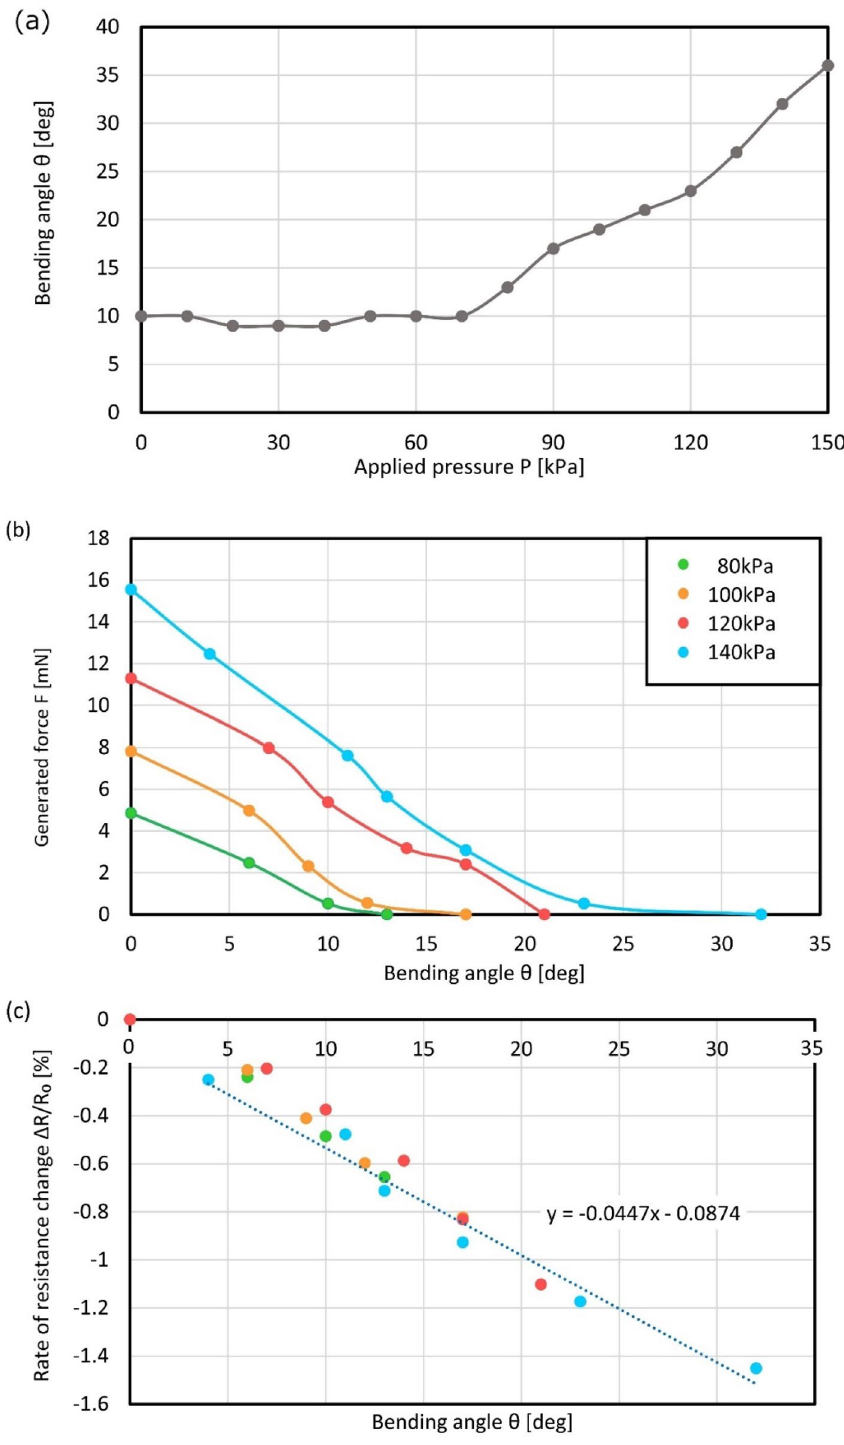
Figure 3. Characterization results of the bending motion of a microfinger and the force generated by a microfinger. ( a ) Characteristics of bending motion by a microfinger. ( b ) Output characteristics of a microfinger in terms of bending angle and generated force in accordance with applied pressure. ( c ) Characteristics of a flexible strain sensor for a microfinger. Data processing software (BenchVue, Keysight, ver. 3.1.1602.19, https:// www. keysi ght. com/ jp/ ja/ lib/ softw are- detail/ compu ter- softw are/ bench vue- insta llati on- wizard- 24174 63. html) was used for signal